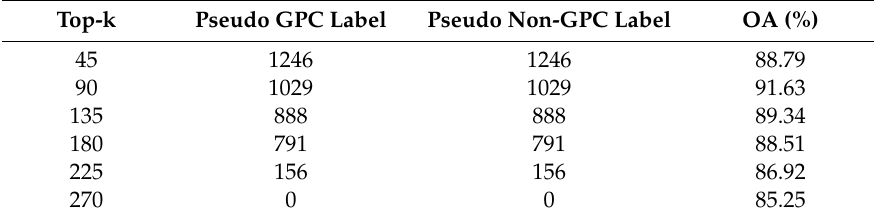
Table 4. k vs. classification